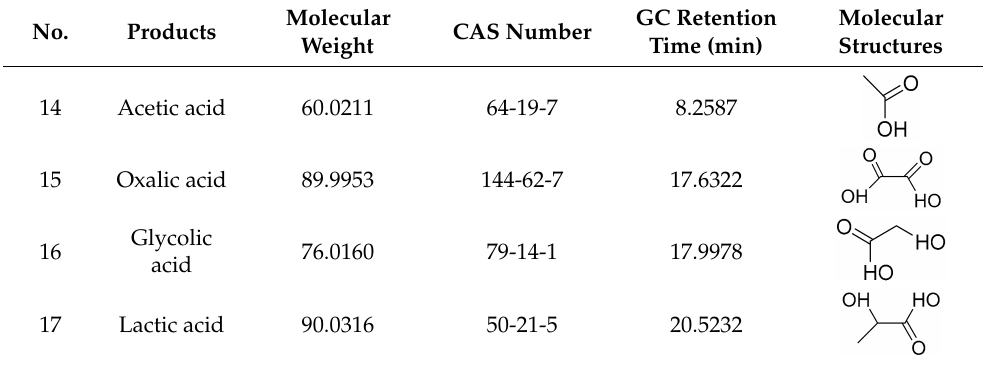
Table 3. Intermediates of AML degradation detected by